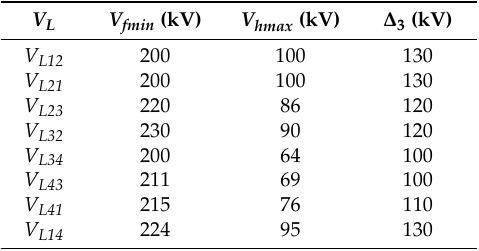
Table 2. Extreme value of V L detected by line protection devices and protection threshold ∆ 3